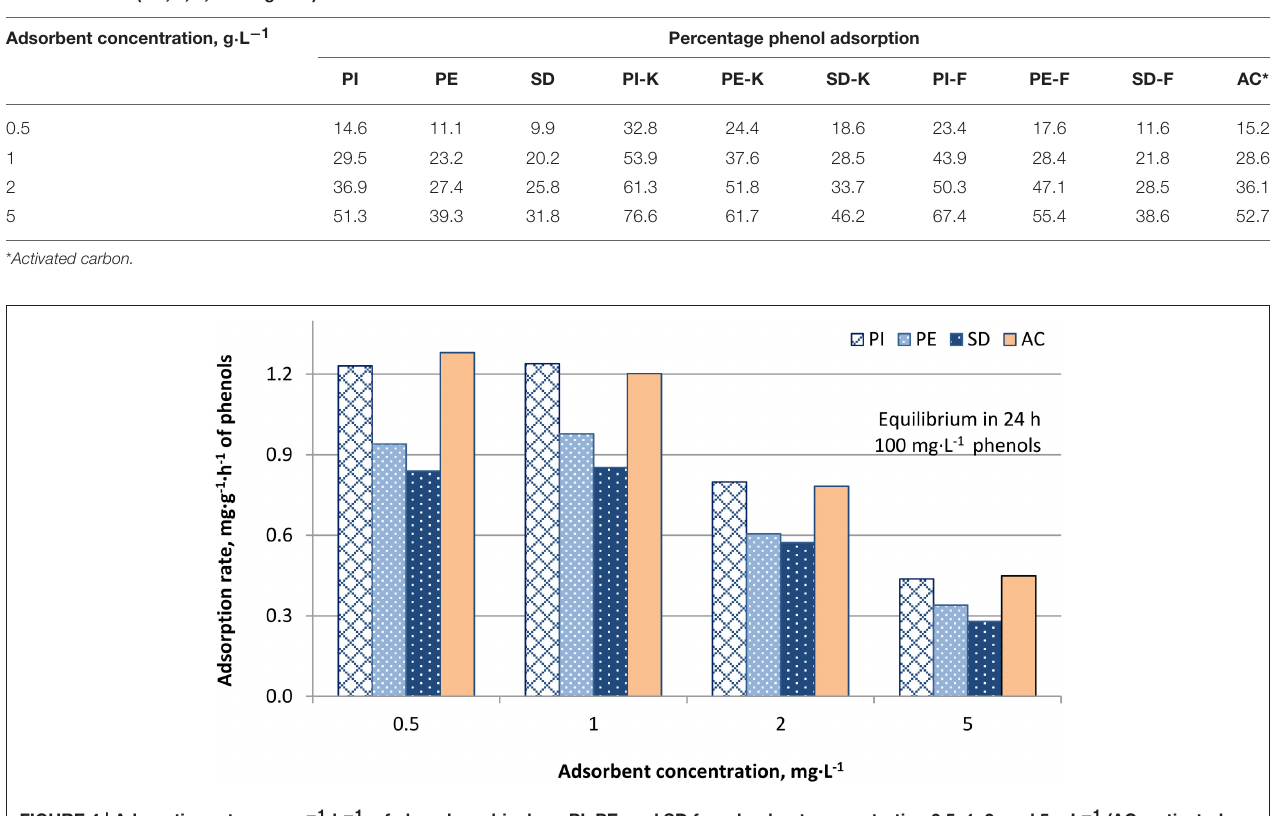
FIGURE 4 | Adsorption rates, mg · g − 1 · h − 1 , of phenols on biochars PI, PE, and SD for adsorbent concentration 0.5, 1, 2, and 5 g · L − 1 (AC: activated carbon, used as reference